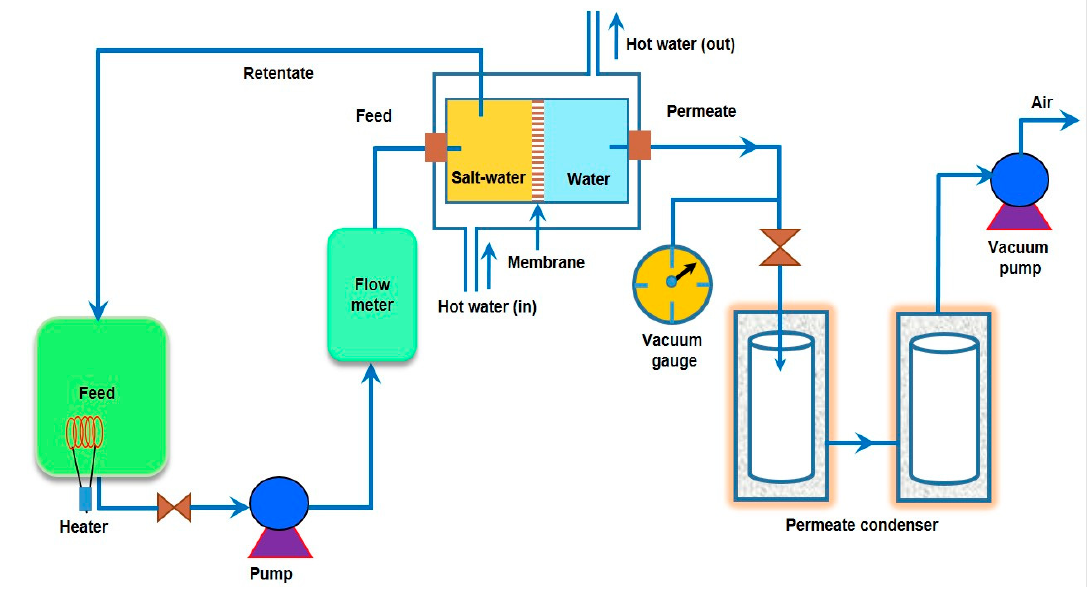
Figure 1. PV desalination apparatus.